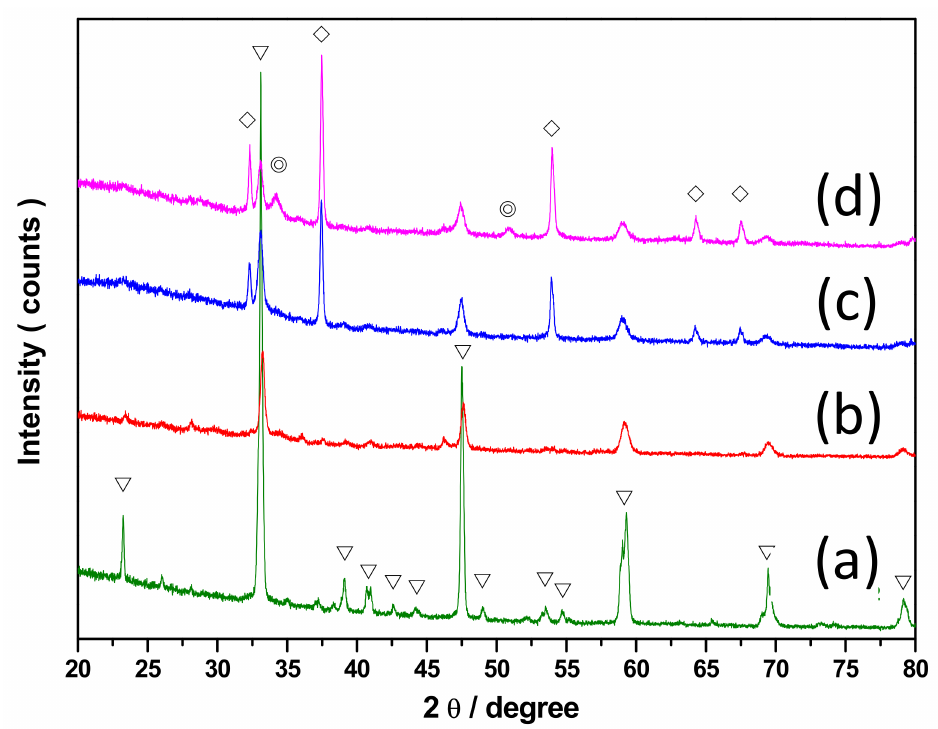
Figure 2. XRD result of as-prepared calcium-based sorbents: ( a ) CaTi-1.2, ( b ) CaTi-2, ( c ) CaTi-3, ( d ) CaTi-5. The inverted triangle symbol, diamond symbol, and circle symbol represent CaTiO 3 , CaO, and Ca(OH) 2 ,